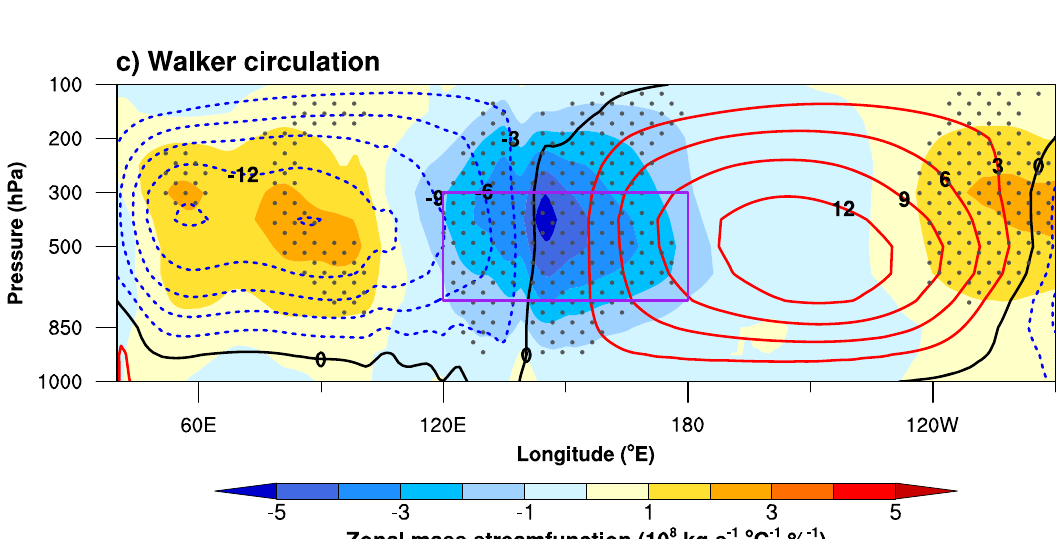
COMMUNICATIONS EARTH & ENVIRONMENT| (2022) 3:310